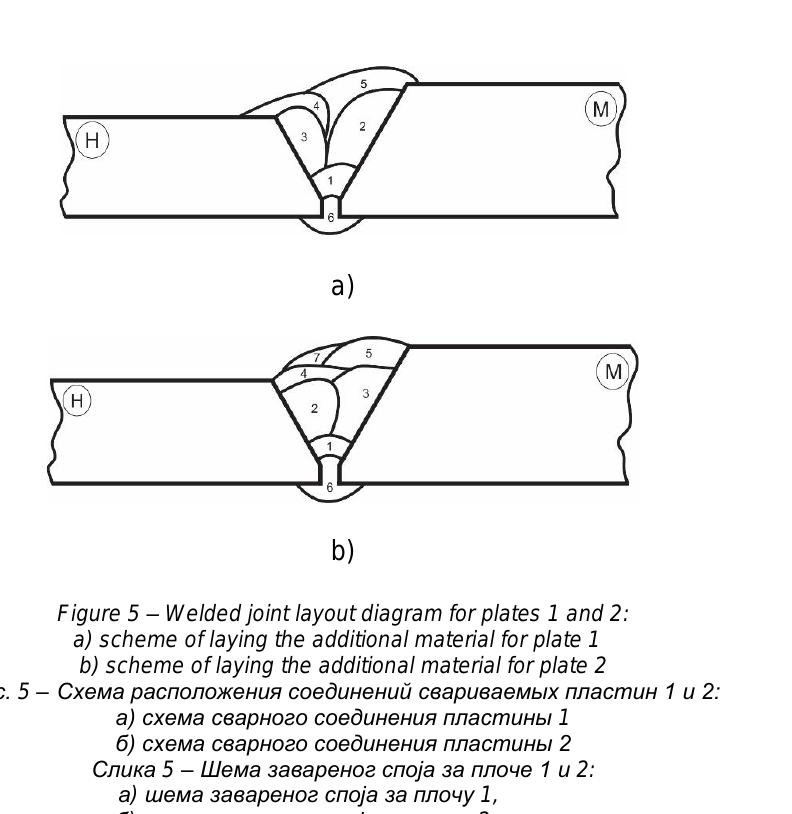
Figure 5 – Welded joint layout diagram for plates 1 and 2: a) scheme of laying the additional material for plate 1 b) scheme of laying the additional material for plate 2 Рис. 5 – Схема расположения соединений свариваемых пластин 1 и